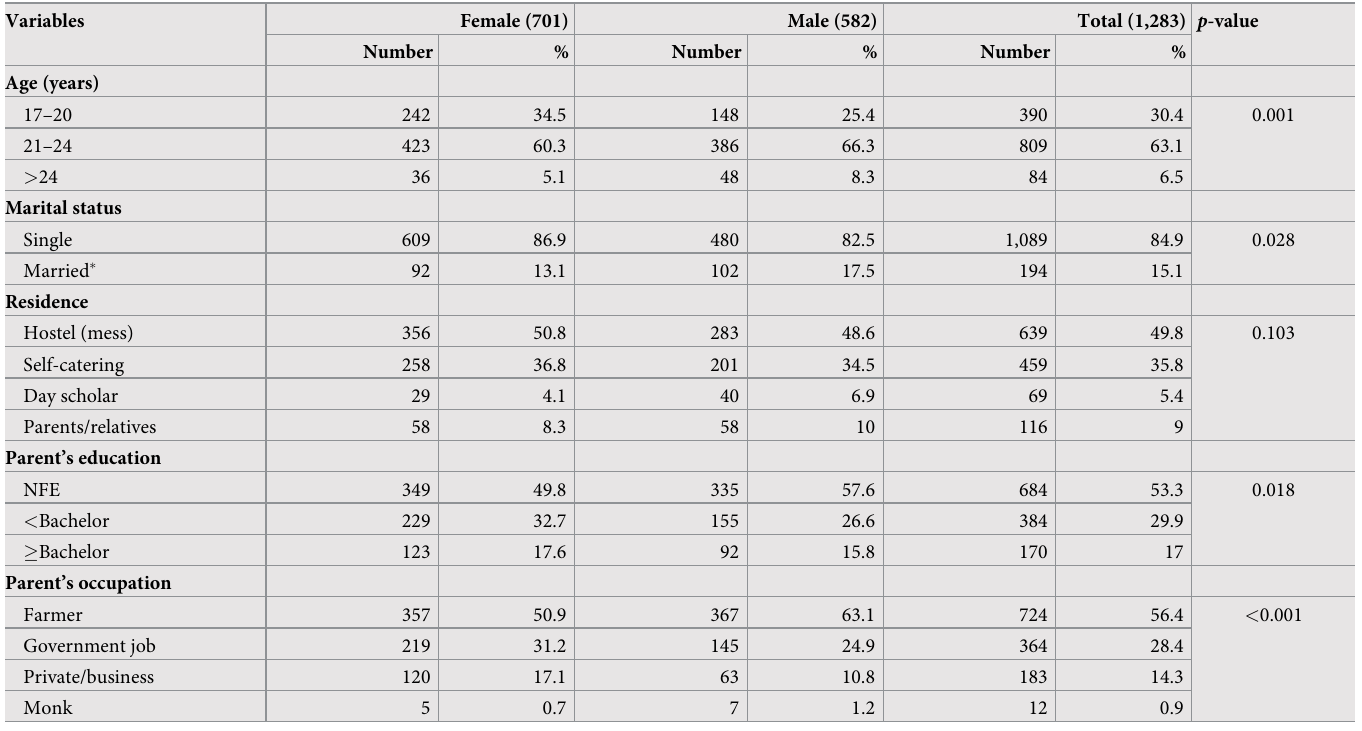
Table 1. Sociodemographic characteristics of the